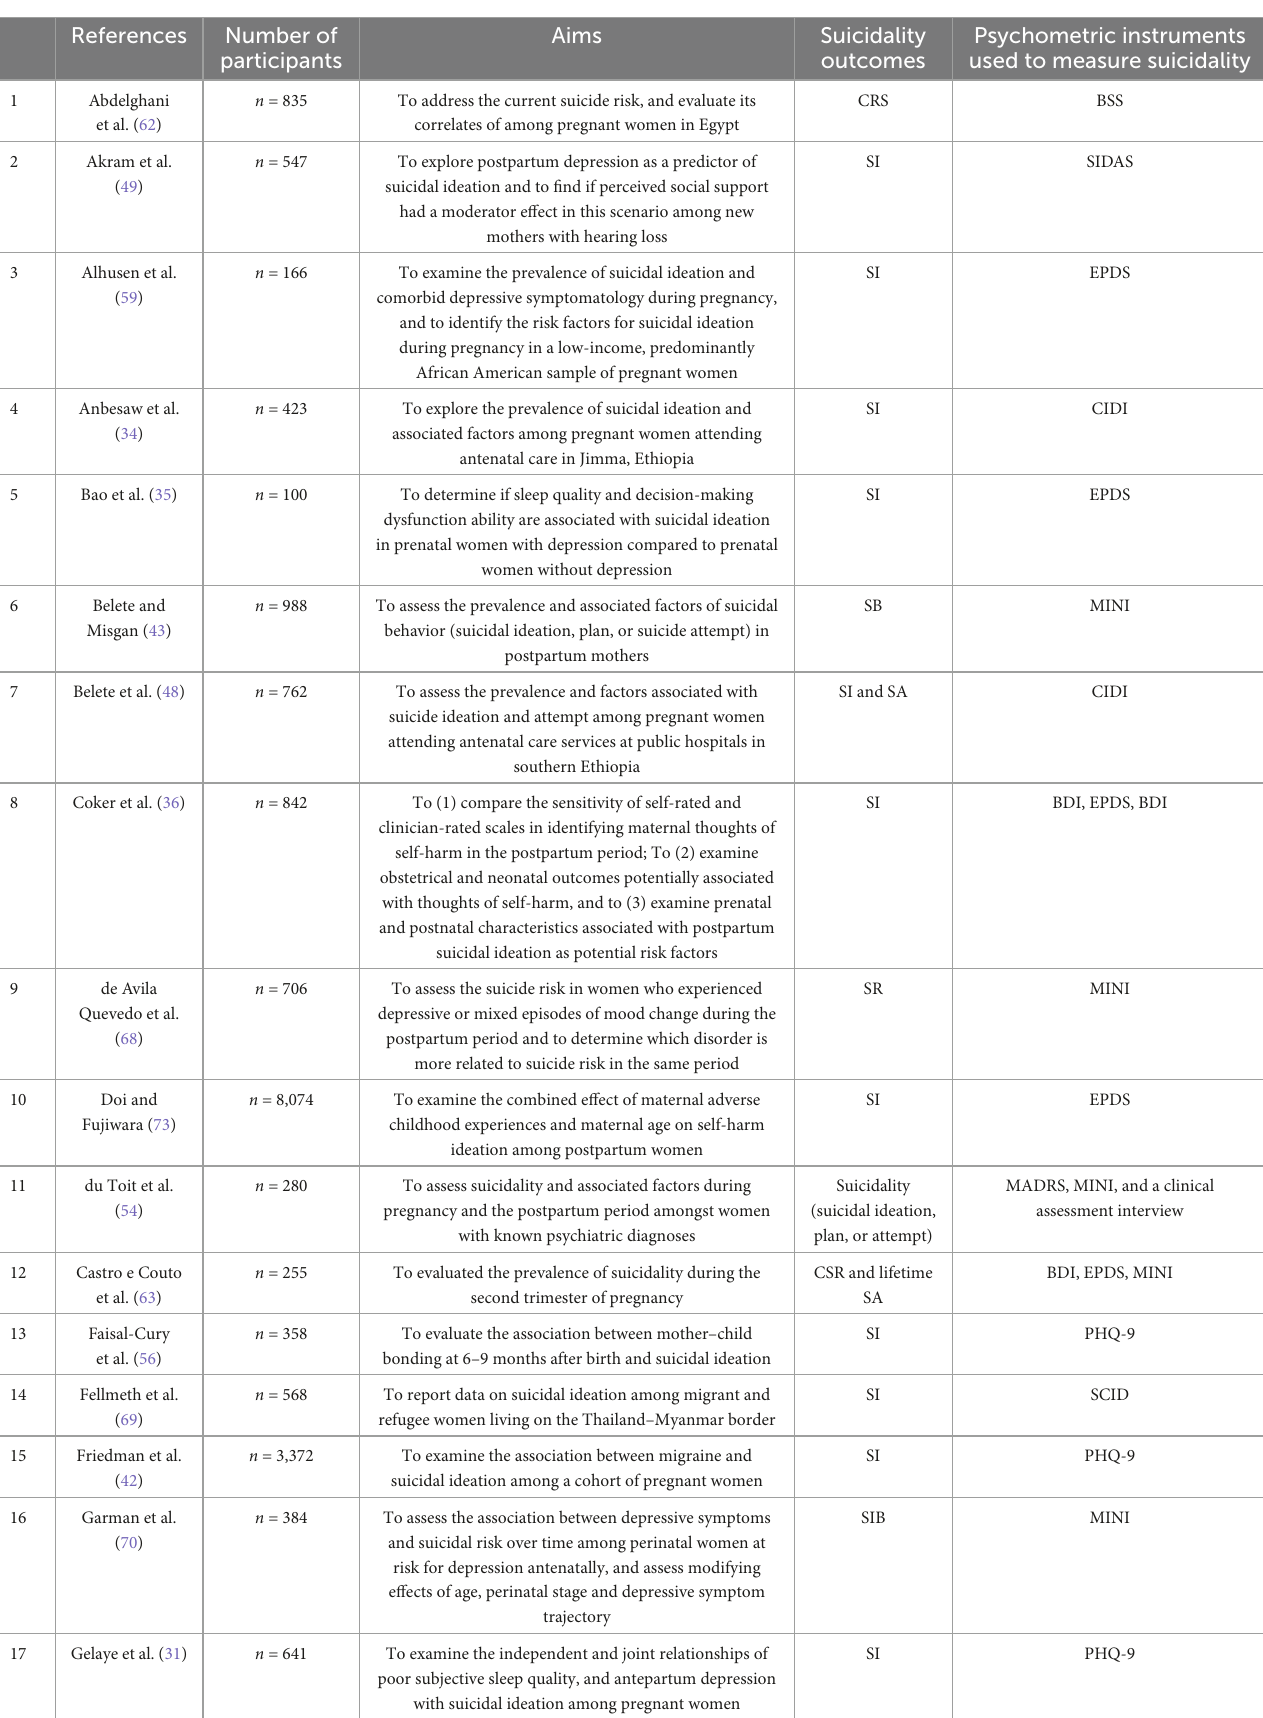
TABLE 1 Distribution of the 51 relevant selected studies including the references, number of participants, aims, suicidality outcomes, and psychometric